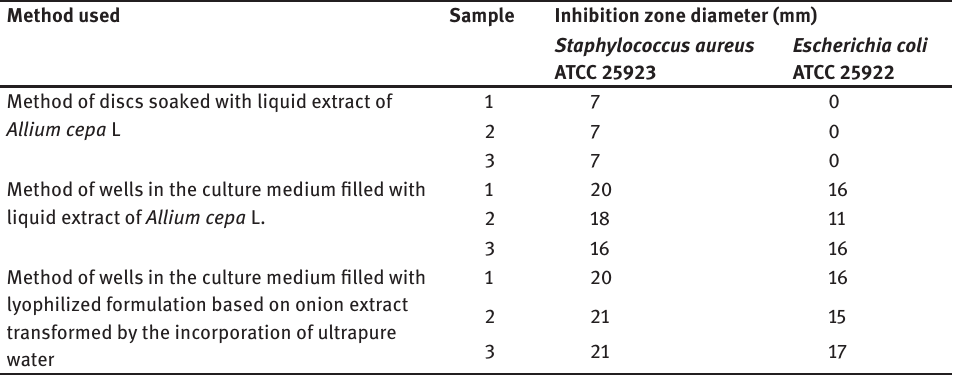
Table 1: Inhibition zone diameter (mm) of A. cepa extracts for the tested bacteria. Method used